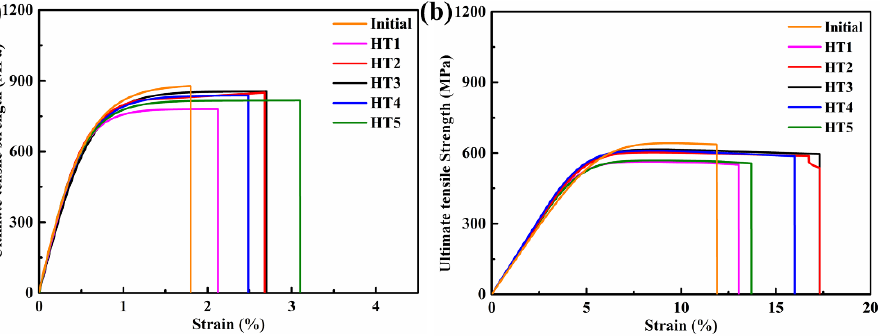
Figure 6. 25 °C and 700 °C tensile properties of initial and heat-treated composites: ( a ) 25 °C tensile Figure 6. 25 ◦ C and 700 ◦ C tensile properties of initial and heat-treated composites: ( a ) 25 ◦ C tensile properties and ( b ) 700 °C tensile properties. properties and ( b ) 700 ◦ C tensile properties. Table 2. Tensile properties of initial and heat-treated